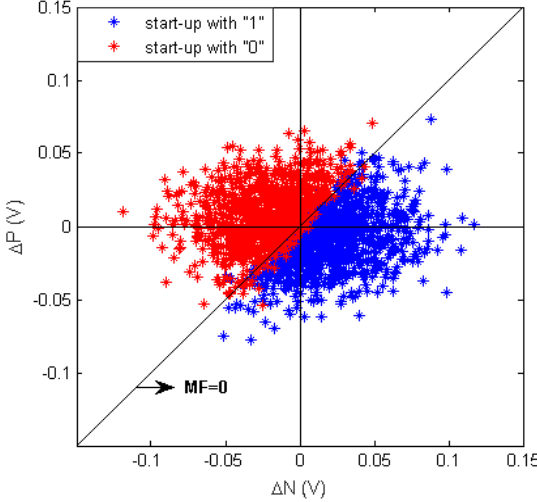
Figure 3. The distribution of threshold voltage fluctuations in NMOS and PMOS transistors.